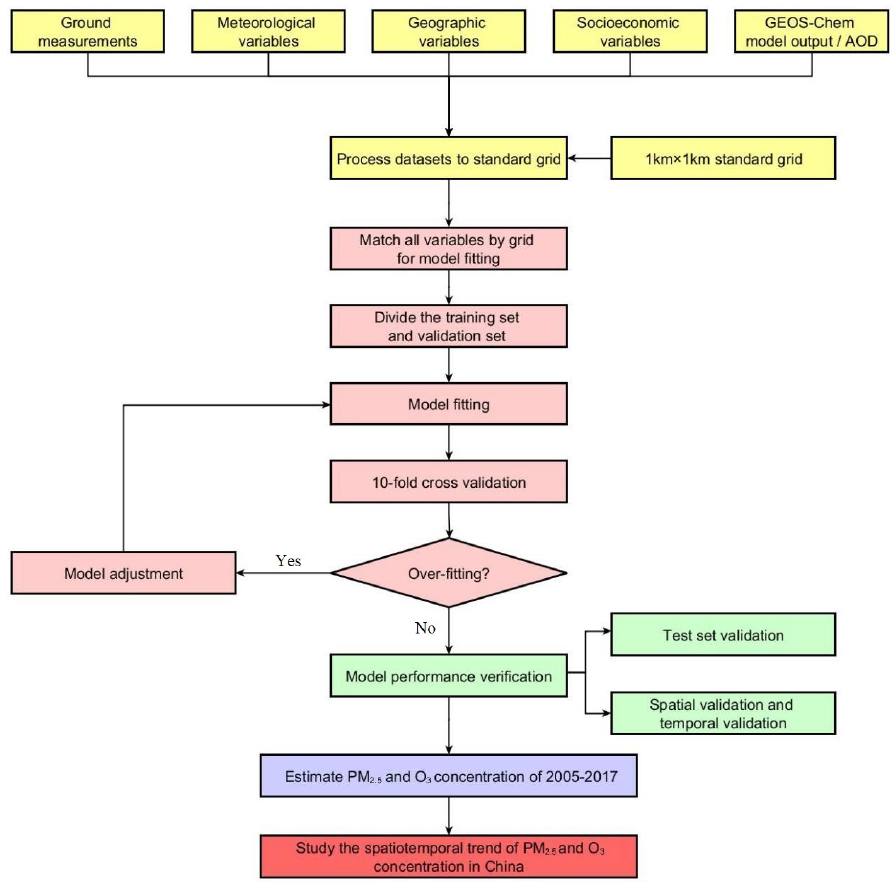
Figure 2. The workflow of modeling process in the